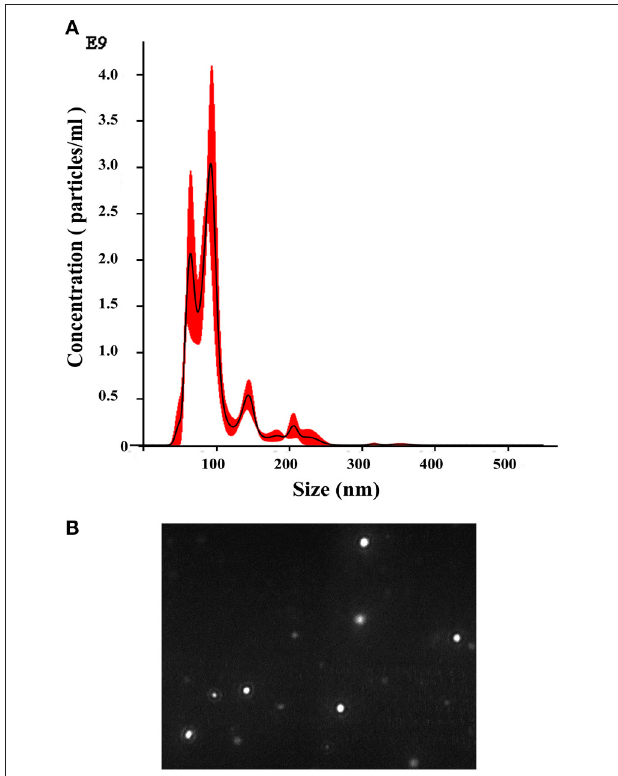
FIGURE 1 | Nanoparticle-tracking analysis of extracellular vesicles (EVs) produced by T. interdigitale . EVs were purified from T. interdigitale culture supernatants and quantified using a NanoSight NS300. (A) Histogram showing the EV particle-size distribution (EVs × 10 9 /mL vs size in nanometers). (B) Screenshot from video recorded using the NanoSight NS300, showing the distribution of EVs from T. interdigitale